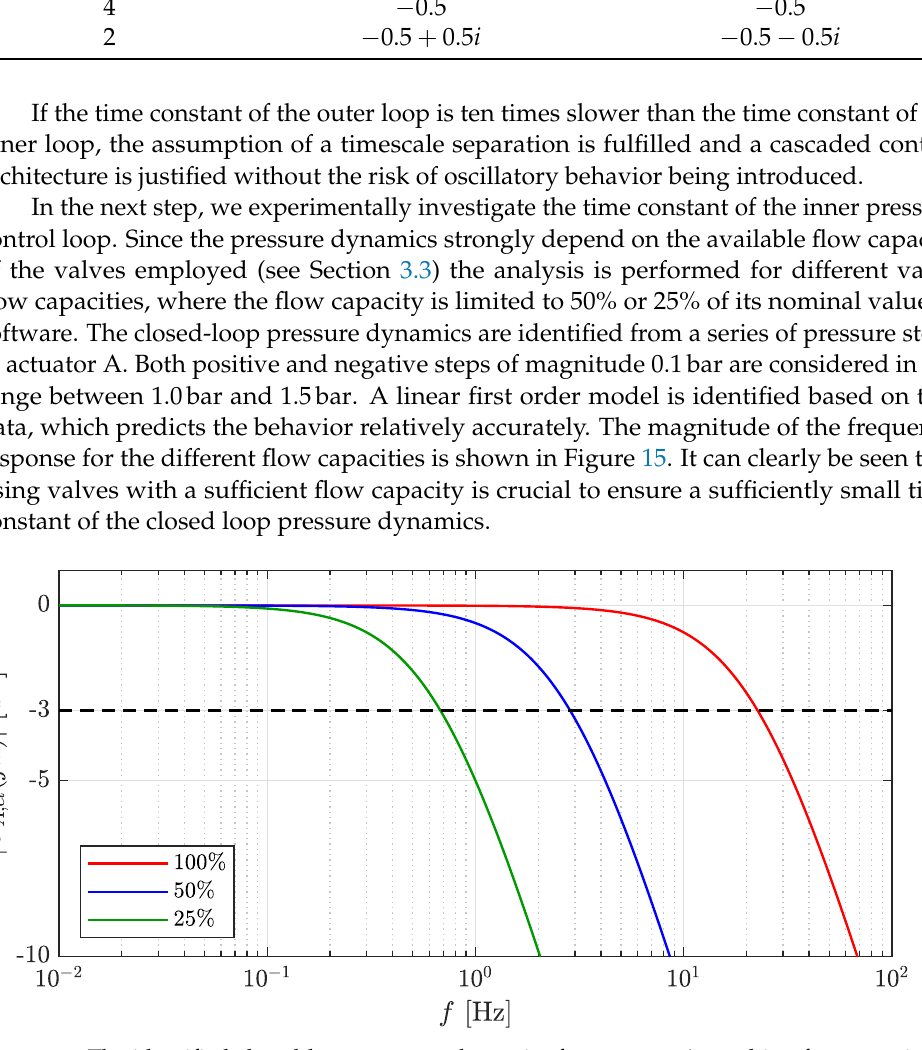
Figure 15. The identified closed-loop pressure dynamics for actuator A resulting from a series of pressure steps. The red curve shows the magnitude of the frequency response when the full flow capacity of the proportional valve is used (100%). The blue and green curves show the magnitude when the flow capacity is limited to 50% and 25% of the nominal value, respectively. The black dashed line indicates the − 3dB line. The cutoff frequencies decrease from 22.7Hz for the red curve to 2.9Hz for the blue curve and 0.7Hz for the green